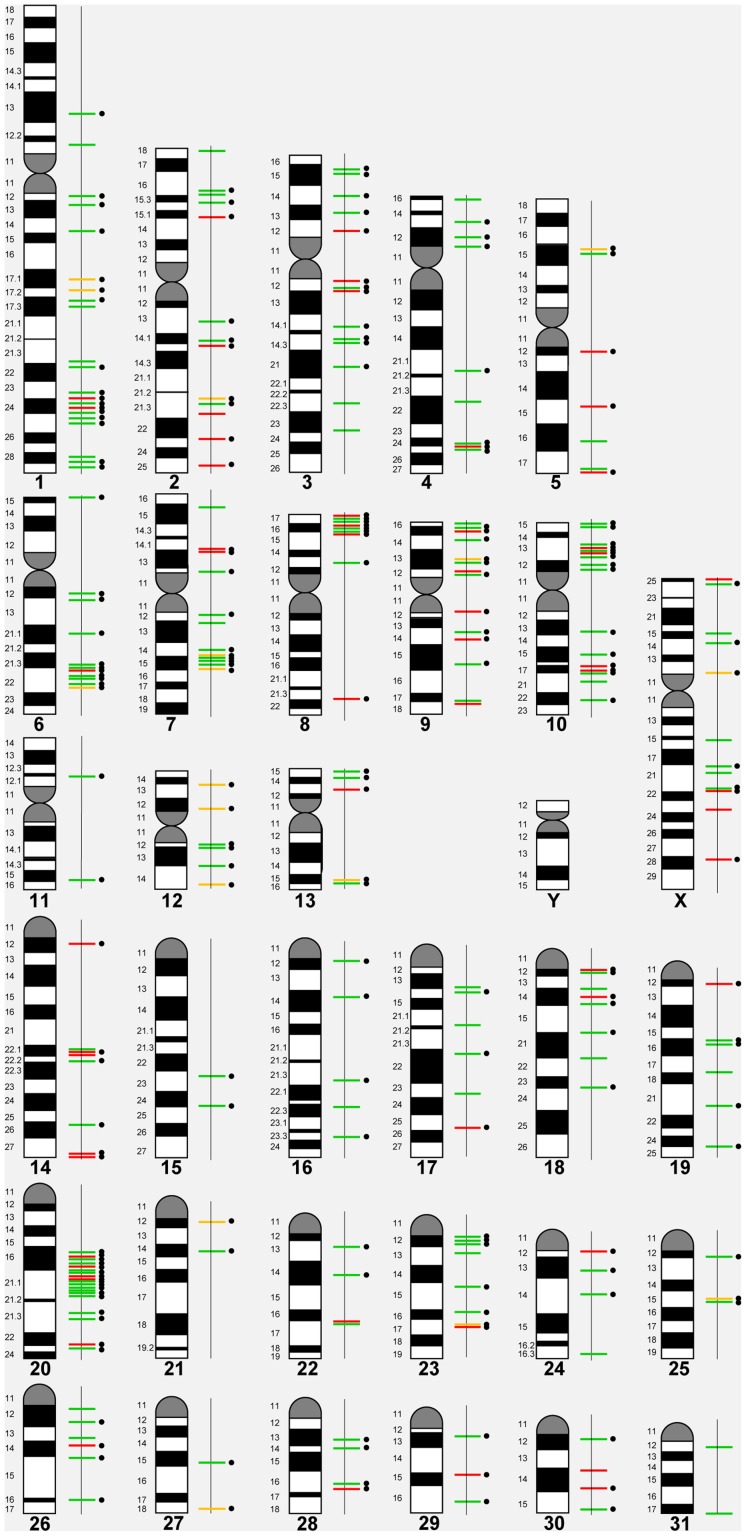
A CNVR map of the horse genome.Green line – loss; red line – gain; yellow line – complex; black dots – genes involved.